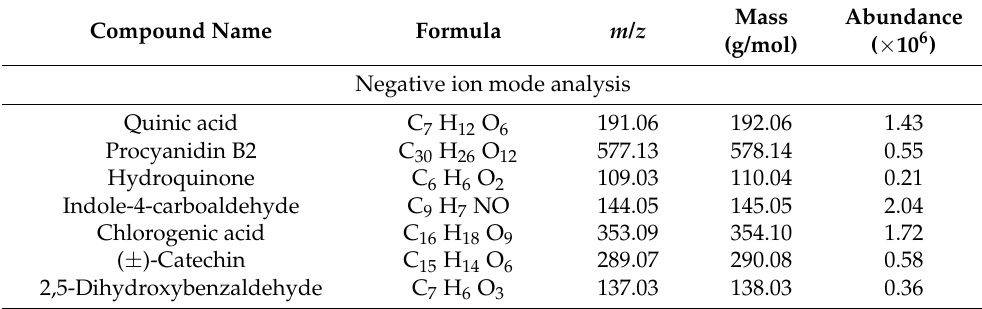
Table 2. LC-MS data of the compounds present in the Duea ching extract prepared using 60% ( v/v ) ethanol